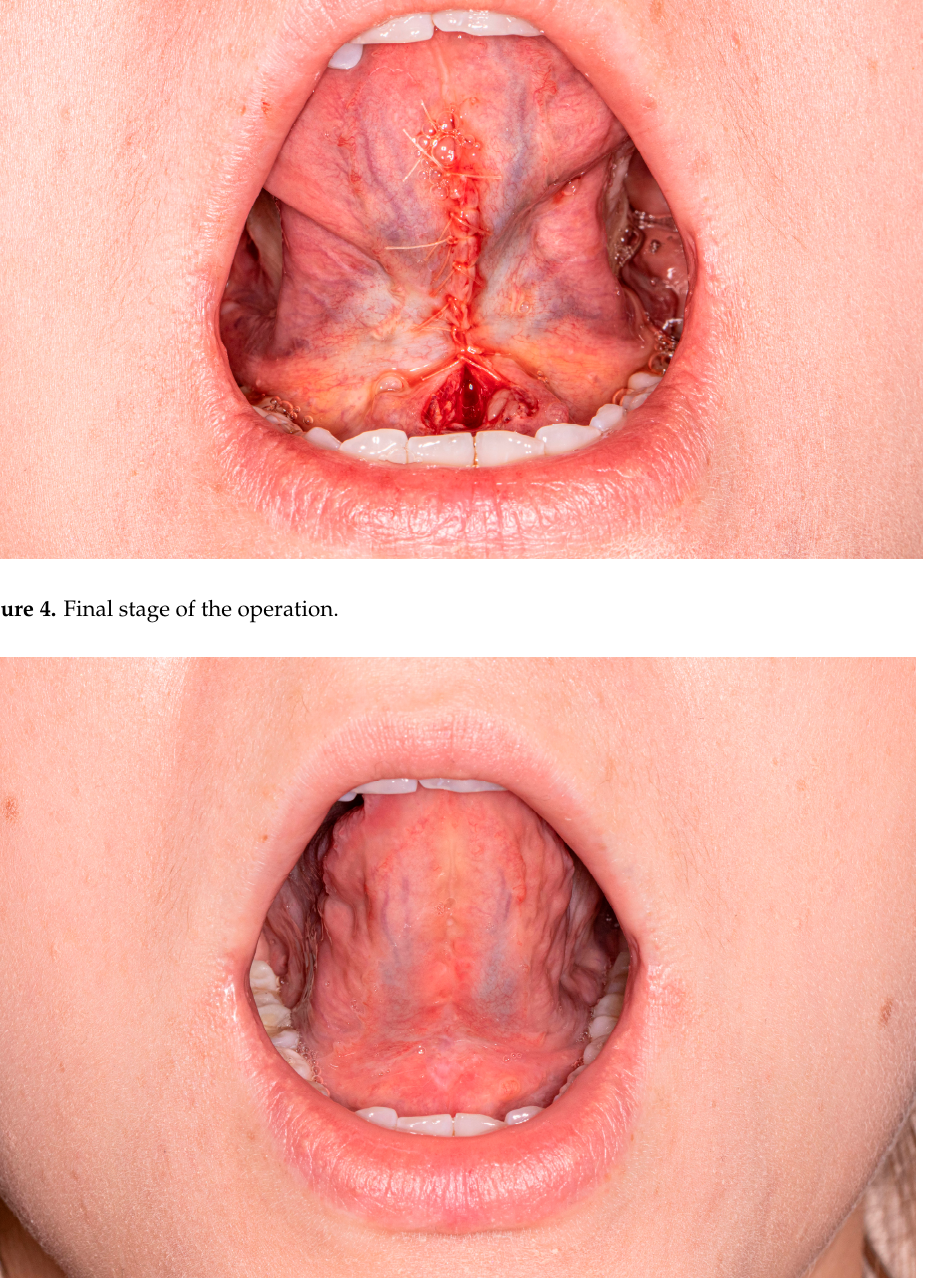
Figure 5. Final result after 1 month (TRMR-TIP 100%) .